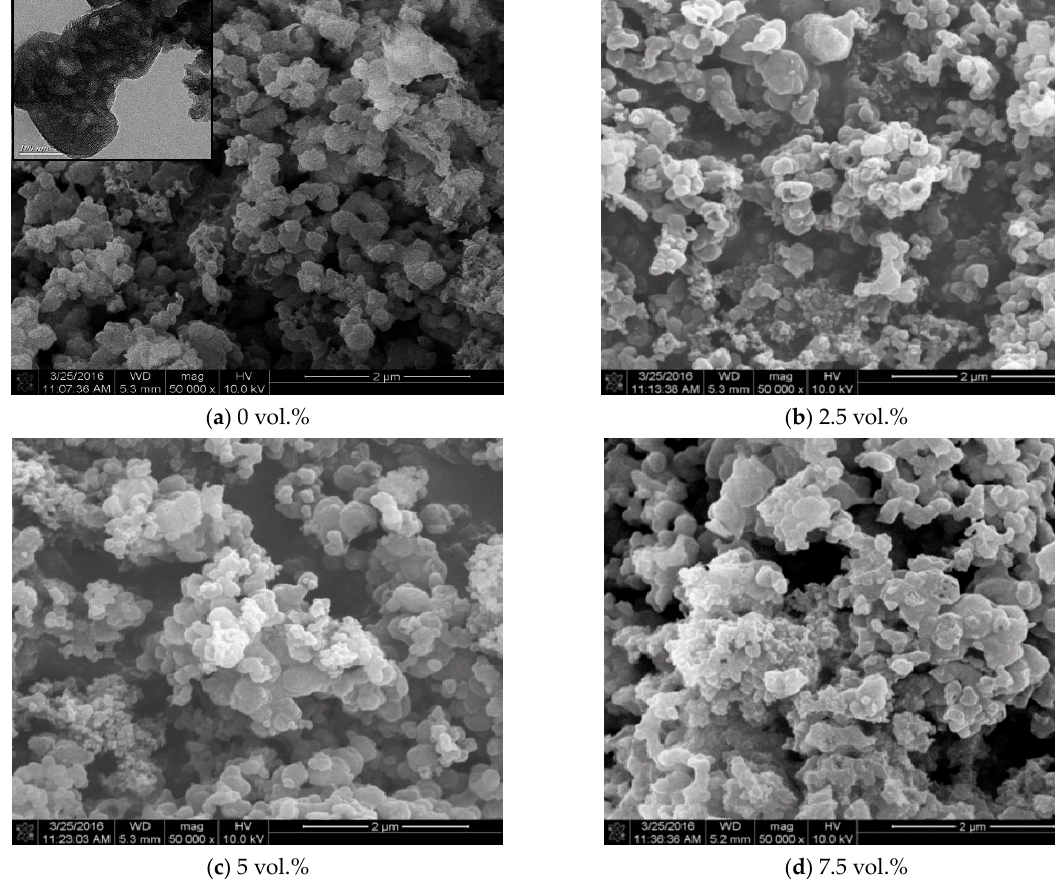
Figure 4. SEM image of grafted NH 2 -Al/MCM-41 with different amine functional groups..